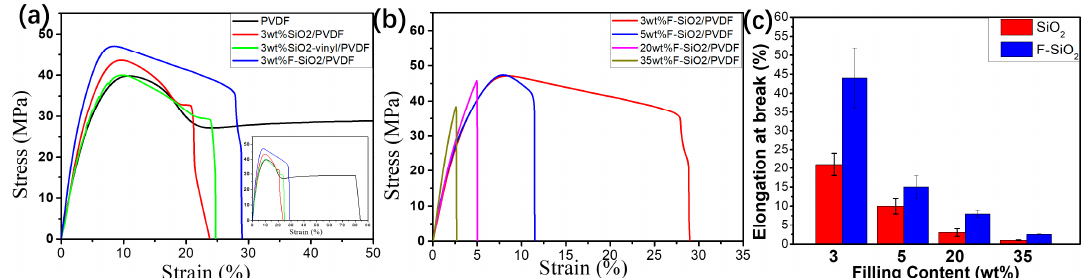
Figure 8. ( a ) Stress-strain curves of the PVDF matrix incorporated with 3 wt% SiO 2 , SiO 2 -vinyl, and F-SiO 2 nanoparticles, respectively. ( b ) Stress-strain curves of the PVDF matrix incorporated with 3 wt%, 5 wt%, 20 wt%, and 35 wt% F-SiO 2 nanoparticles, respectively. ( c ) The elongation at break